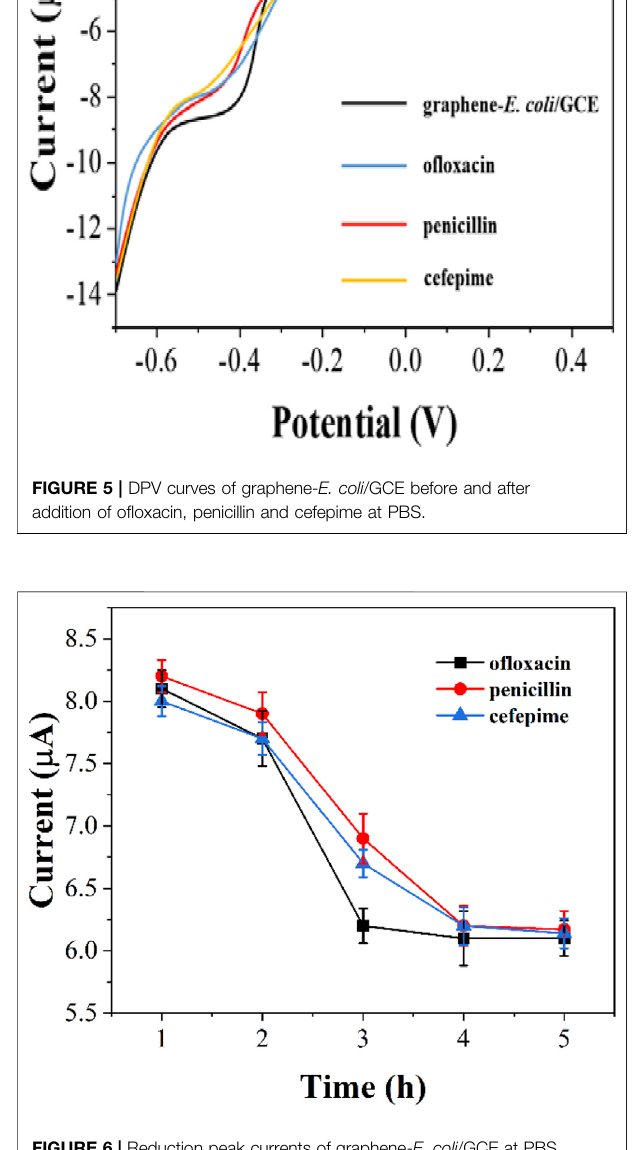
FIGURE 6 | Reduction peak currents of graphene- E. coli /GCE at PBS after addition of o fl oxacin, penicillin and cefepime ( n (cid:2)